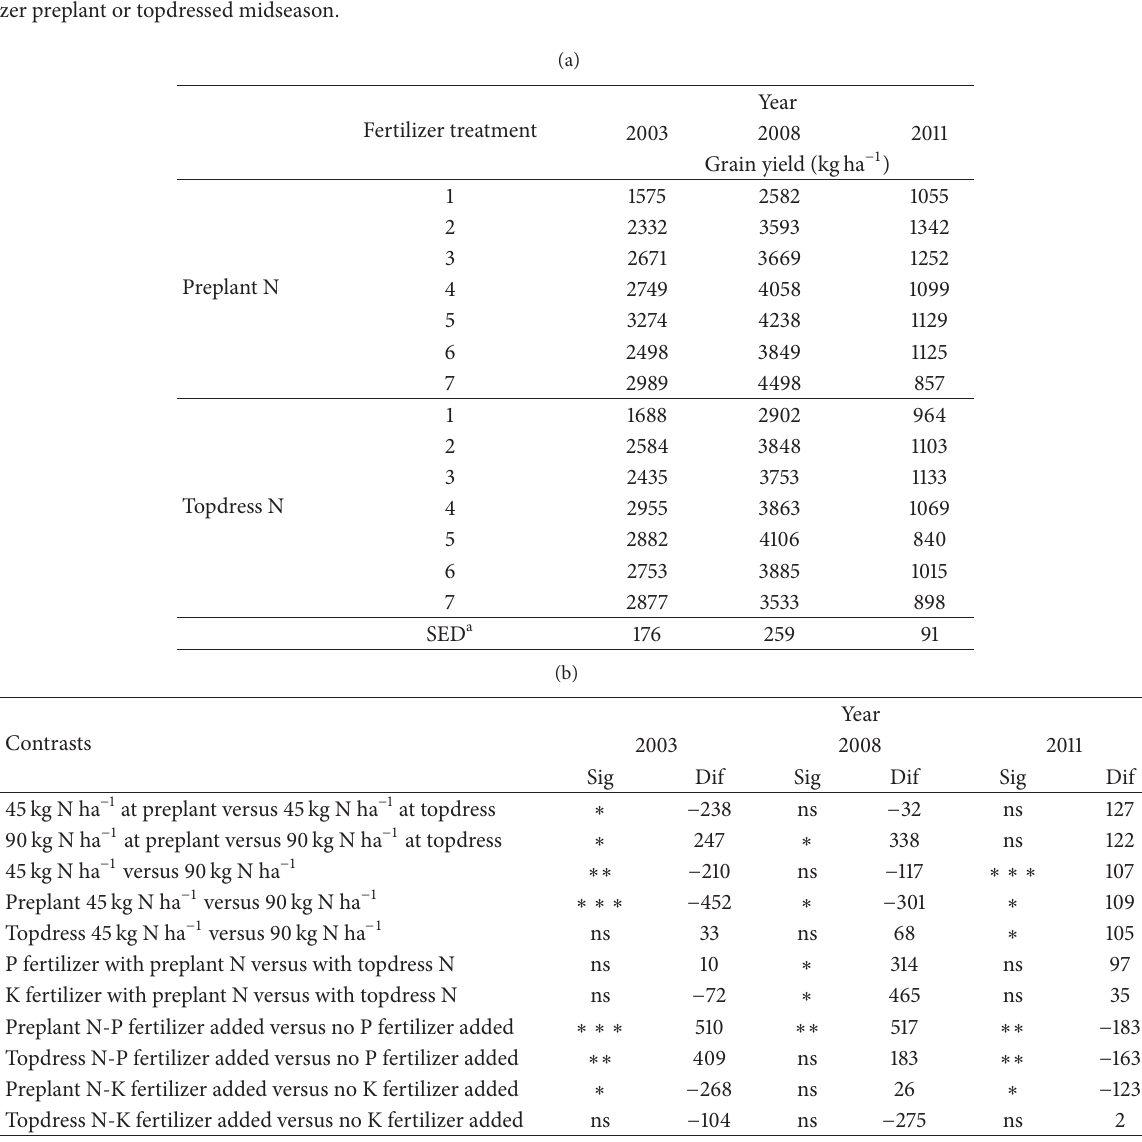
Table 5: Grain yield means and selected contrasts by year for plots with different fertilizer treatments and those received either their total N fertilizer preplant or topdressed